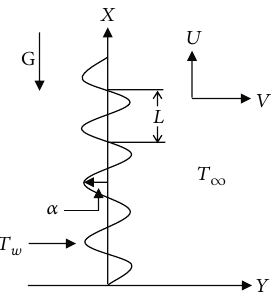
Figure 1: Physical model with coordinate